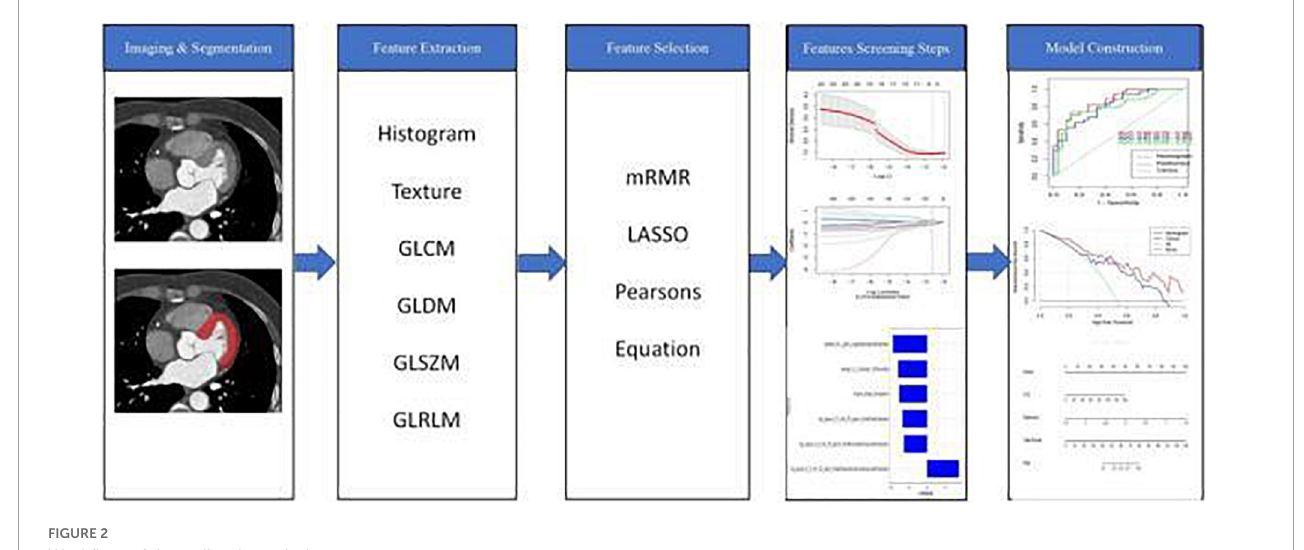
FIGURE2 Workflow of the radiomic analysis.